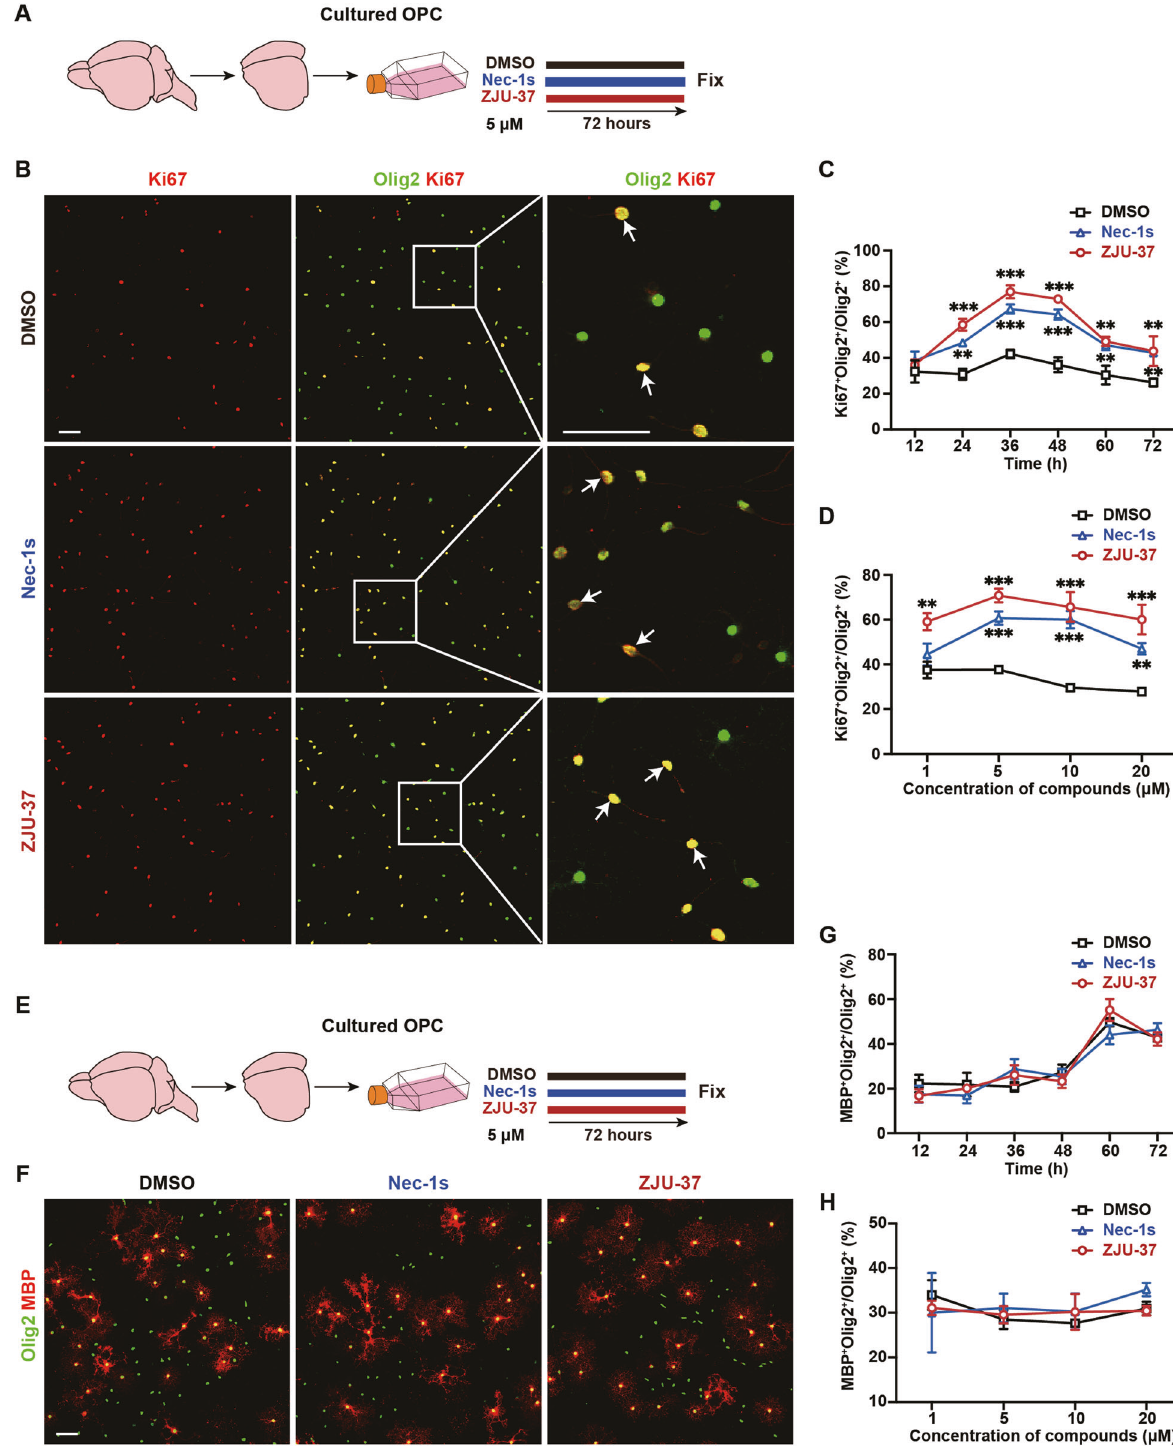
Fig. 3 ZJU-37 promotes OPC proliferation in vitro with higher ef fi cacy than Nec-1s. A Schematic diagram of the experiment for testing OPC proliferation in vitro. B Representative fl uorescence images of proliferating primary rat OPCs treated with DMSO, Nec-1s (5 μ M) or ZJU-37 (5 μ M) for 36 h. Proliferating OPCs was visualized by Ki67 (red) and Olig2 (green). Scale bars, 50 μ m. Quanti fi cation of proliferating OPCs over ( C ) time and ( D ) concentration of compounds (two-way repeated ANOVA, Sidak ’ s post hoc test, n = 3 plate wells). E Schematic diagram of the experiment for testing OPC differentiation in vitro. F Representative fl uorescence images of differentiated primary rat OPCs treated with DMSO, Nec-1s or ZJU-37 for 48 h. Differentiated mature oligodendrocyte was visualized by MBP (red) and Olig2 (green). Scale bars, 50 μ m. Quanti fi cation of differentiated OPC over ( G ) time and ( H ) drug concentration (two-way repeated ANOVA, Sidak ’ s post hoc test, n = 3 plate wells). All data are presented as mean ± SEM. * P < 0.05, ** P < 0.01, *** P < 0.001, n.s. no signi fi cance.